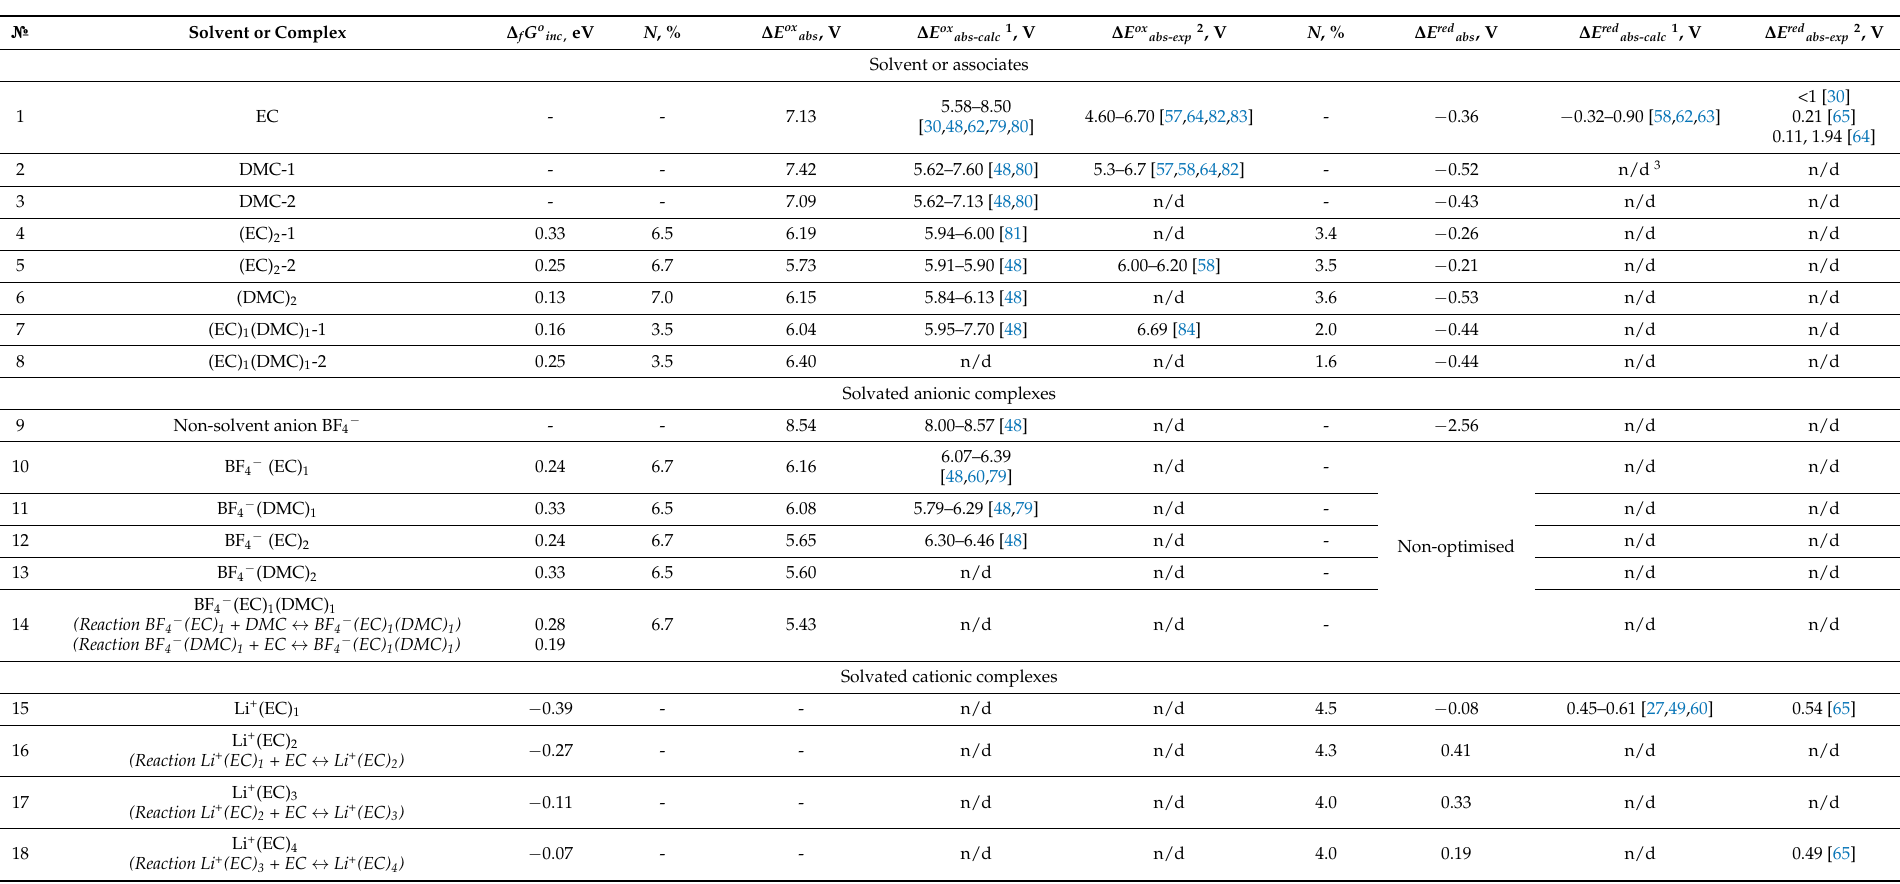
Table A1. Thermodynamic and oxidative parameters of solvent molecules and various complexes existing in the system 1 m LiBF 4 EC/DMC: ∆ f G o inc —incremental (stepped) Gibbs energy of formation (eV); N —Maxwell–Boltzmann energy distribution; ∆ E ox abs —adiabatic oxidation potential estimated in this work (M052X/TZVP); ∆ E ox abs-calc —adiabatic oxidation potential, published earlier, estimated on the basis of quantum chemical calculations; the oxidation potential; ∆ E red abs —adiabatic reduction potential estimated in this work (M052X/TZVP); ∆ E red* abs-calc —adiabatic reduction potential published earlier, which was estimated on the basis of quantum chemical calculations; ∆ E red* abs-exp —experimentally measured value of the reduction